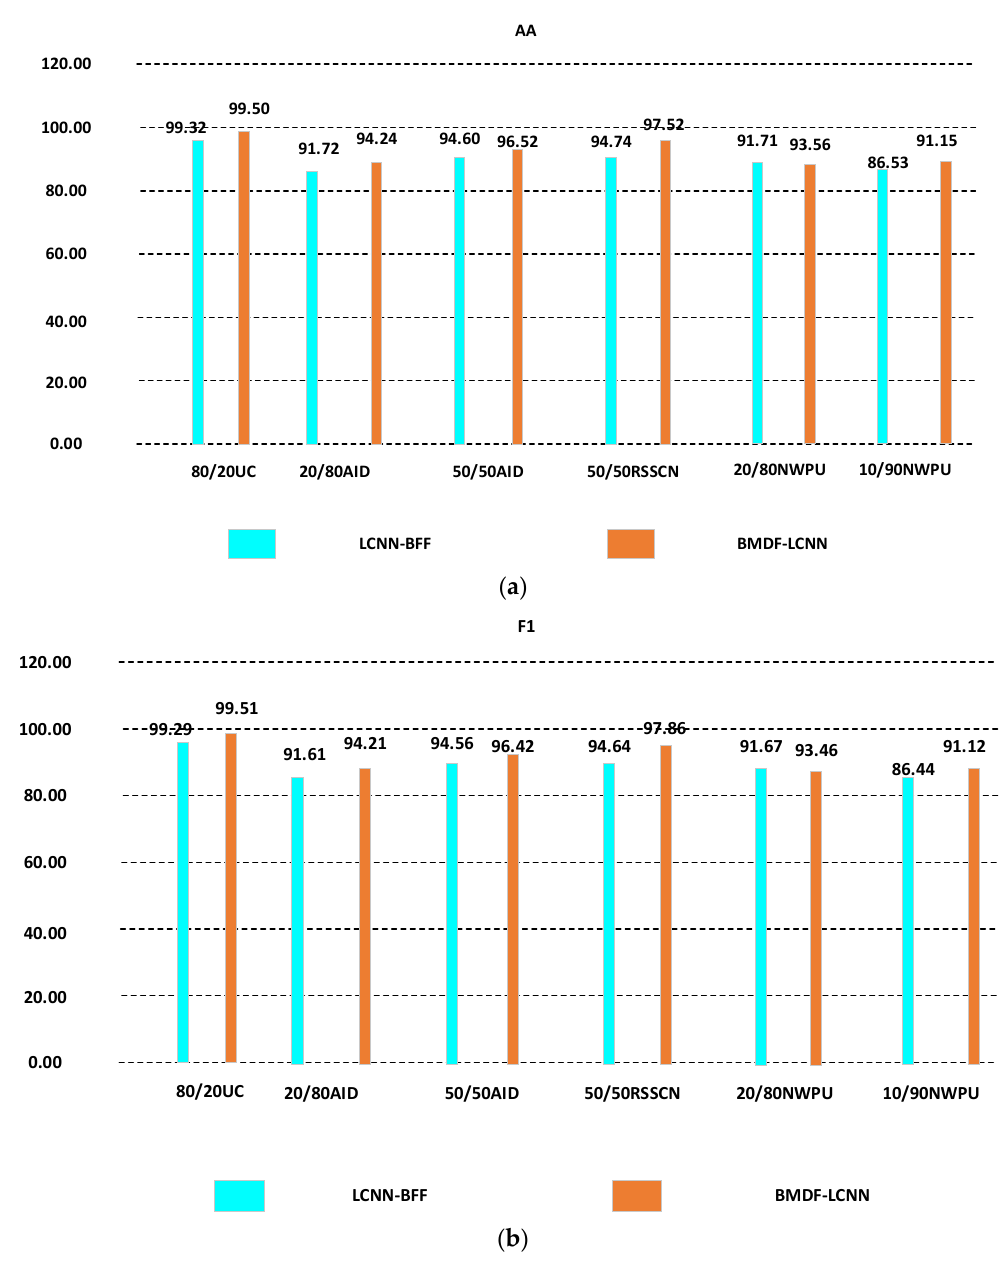
Figure 4. Performance comparison of BMDF-LCNN and LCNN-BFF. ( a ) Comparison of AA values between BMDF-LCNN and LCNN-BFF. ( b ) Comparison of F1 values between BMDF-LCNN and LCNN-BFF.